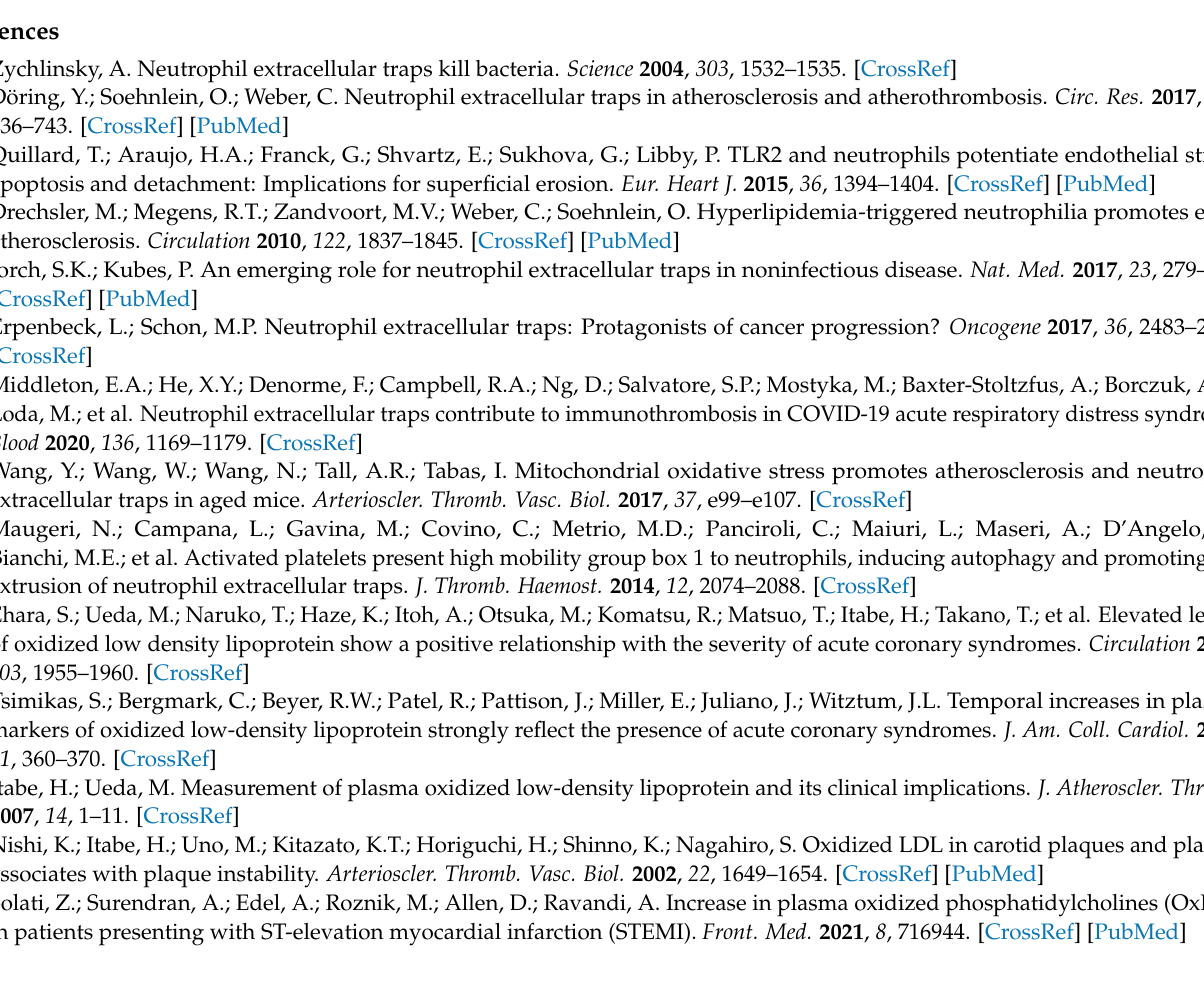
Figure S3: Fluorometric intensity of extracellular DNA treated with various